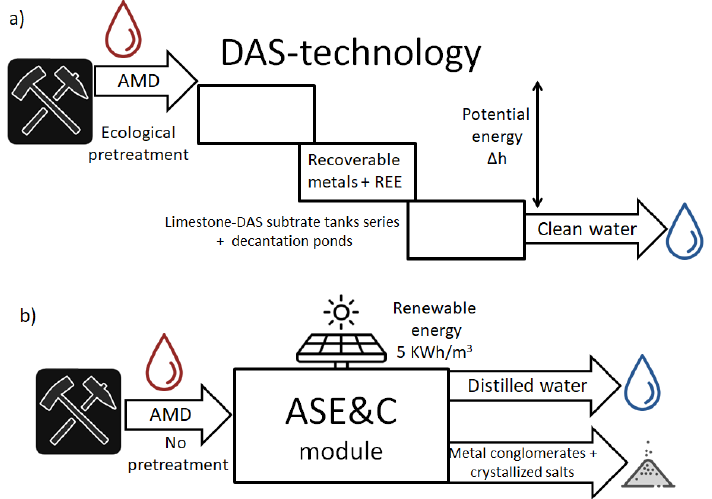
Figure 2. Working scheme of DAS technology ( a ) and ASE&C technology ( b ).